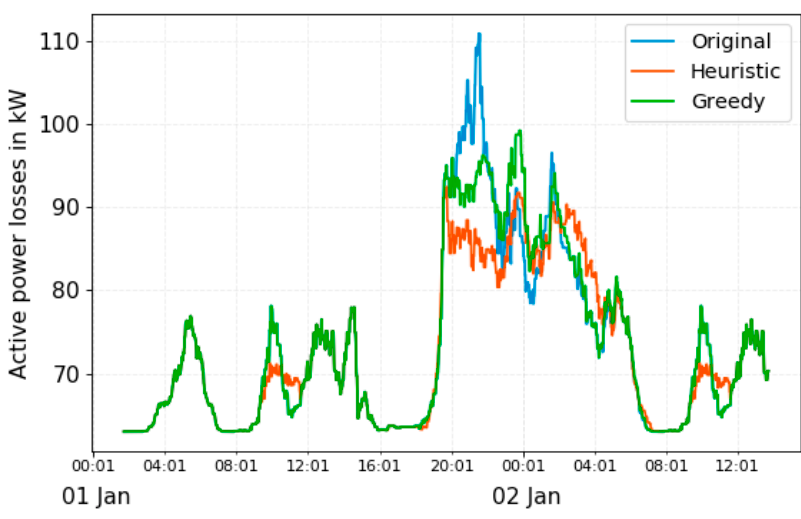
Figure 11. Losses in transformers and cables resulting from the original, greedy and heuristic schedule.